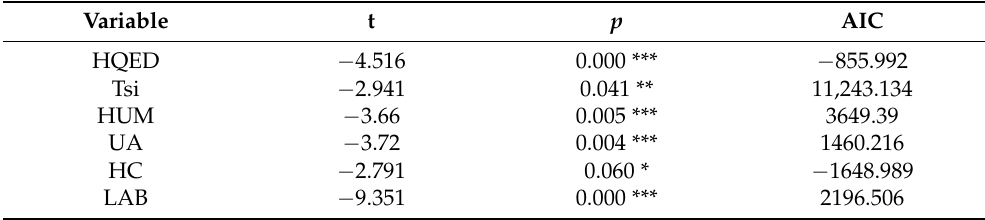
Table 3. Unit root test